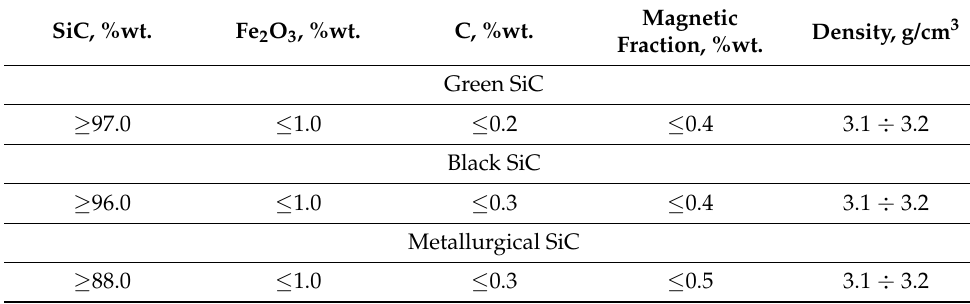
Table 1. Properties of silicon carbide [11]. SiC,